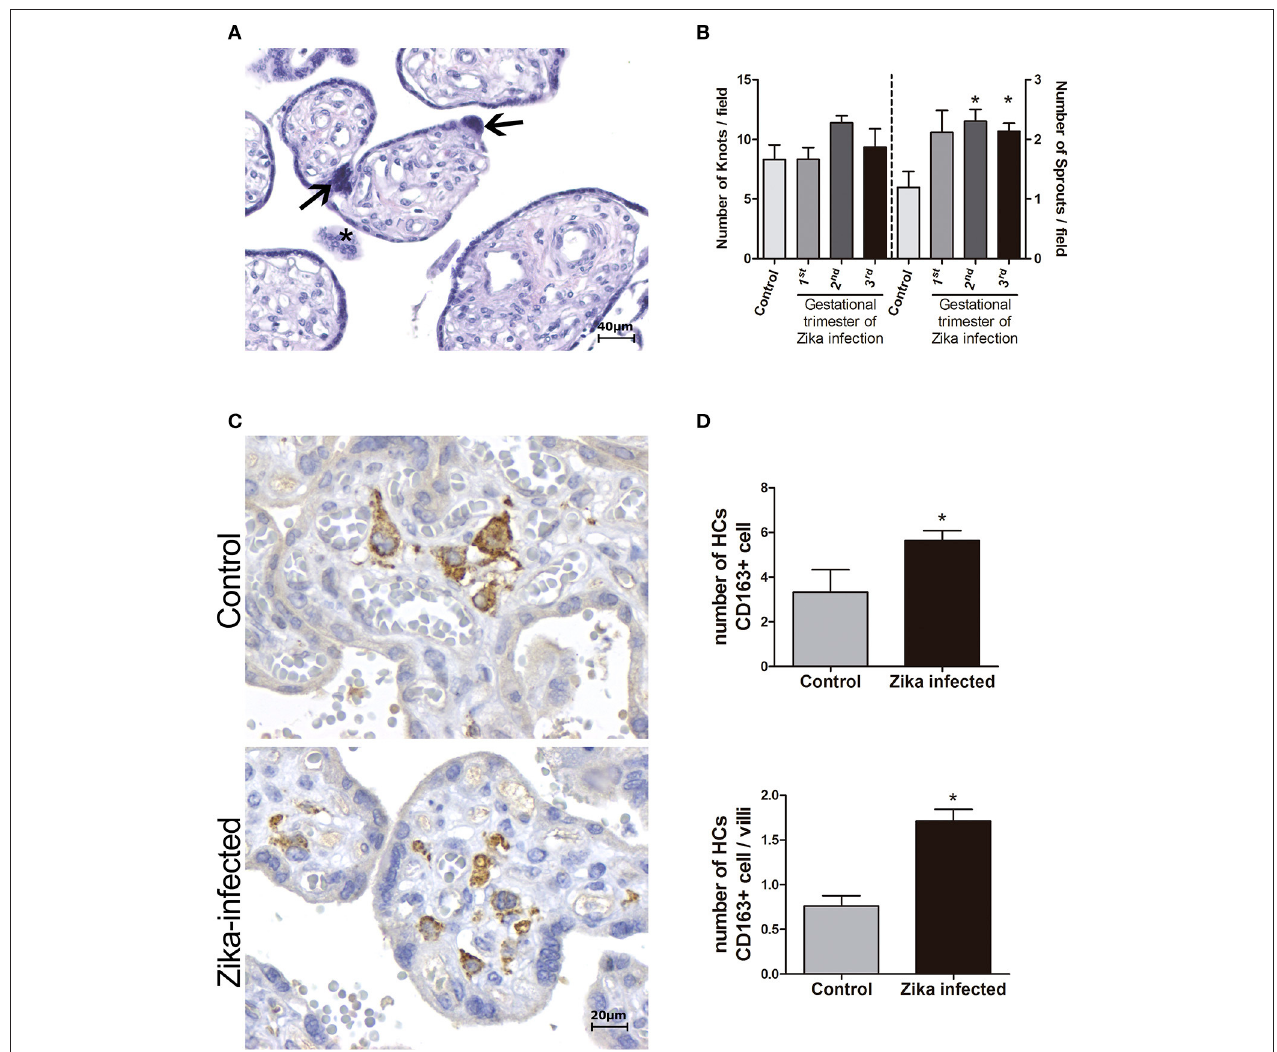
FIGURE 2 | Morphometric analysis of placental specimens from women infected with ZIKV during the pregnancy and from negative controls. (A) Photomicrography of a placental sample stained with H&E showing syncytial knots (arrows) and sprouts (*). (B) Quantification of knots and sprouts. A significant increase in the number of placental sprouts was observed in the groups whose mothers were infected with ZIKV during the first ( n = 4), second ( n = 7), or third ( n = 6) trimester of pregnancy, when compared to the negative controls ( n = 6). (C) Immunostaining with CD163 highlights Hofbauer cell hyperplasia in ZIKV-infected placentas. (D) Quantification of CD163 + Hofbauer cells. The average numbers of CD163 + cells and CD163 + cells per villus were significantly higher in the ZIKV-positive group ( n = 5) than in the negative controls ( n = 3). (B,D) Thirty high-power fields (HPFs = 400 × ) for each case were randomly selected for counting. The mean of the 30 fields was used for the statistical analyses. The Zika-infected and negative control groups were compared using either the One-way ANOVA followed by Dunnett’s multiple comparison test (B) or the Mann Whitney test (D) . The asterisks indicate statistically significant differences between the groups (* p < 0.05).